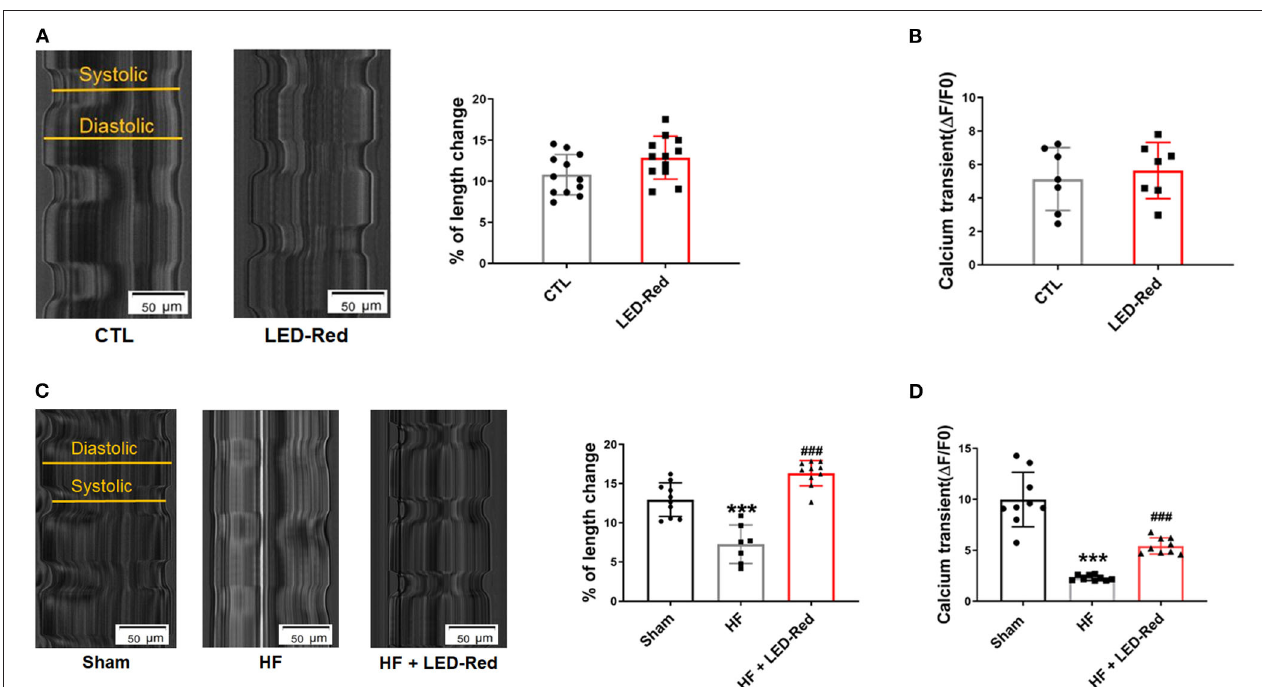
FIGURE 5 | LED-Red irradiation enhances cardiomyocytes contractility. (A) Shortening of isolated single ventricular myocytes of mice. Scale bar = 50 µ m. n = 12. (B) Peak calcium transient analysis in isolated single ventricular myocytes of mice, n = 7. (C) Shortening of isolated single ventricular myocytes of Sham mice or HF